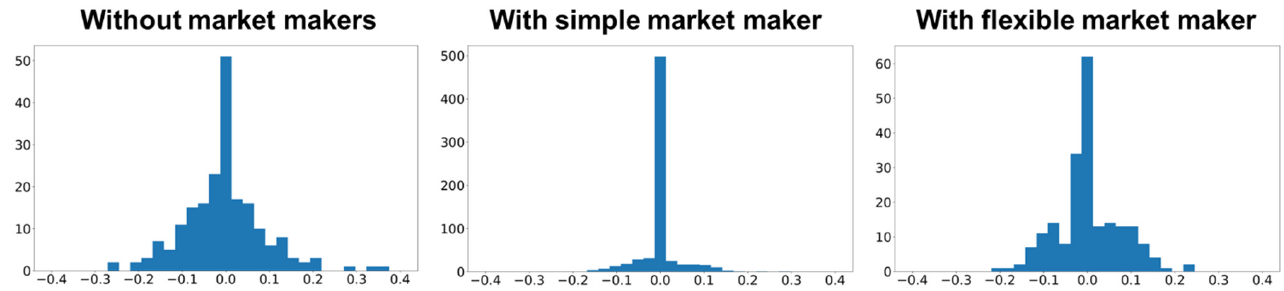
Figure 12. Histograms of execution price change rates for the three cases (horizontal axis: execution price change rate; vertical axis: frequency).